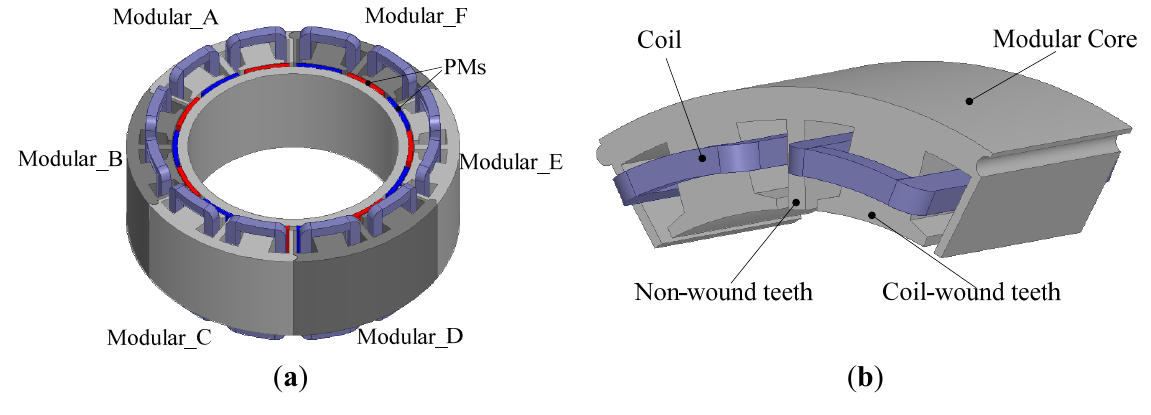
Figure 8. The 24-slot/14-pole modular six-phase PMSM: ( a ) segment-stator 24-slot/14-pole PMSM; and ( b ) modular armature core.